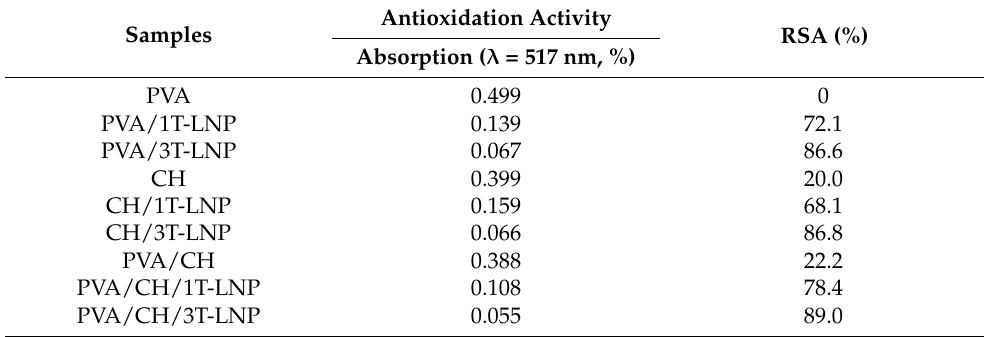
Figure 9. Antioxidant activities of migrating substances for different PVA nanocomposite films im- mersed directly in the methanol solution for 24 h: ( a ) monitoring of the absorbance for band at 517 nm and ( b ) color variation of the DPPH methanol solution: From left to right: PVA (control), PVA/1T-LNP, PVA/3T-LNP; CH, CH/1T-LNP, CH/3T-LNP; PVA/CH, PVA/CH/1T-LNP, PVA/CH/3T-LNP. Table 6. Antioxidation activity of the migrating substances for PVA, CH and PVA/CH/T- LNP